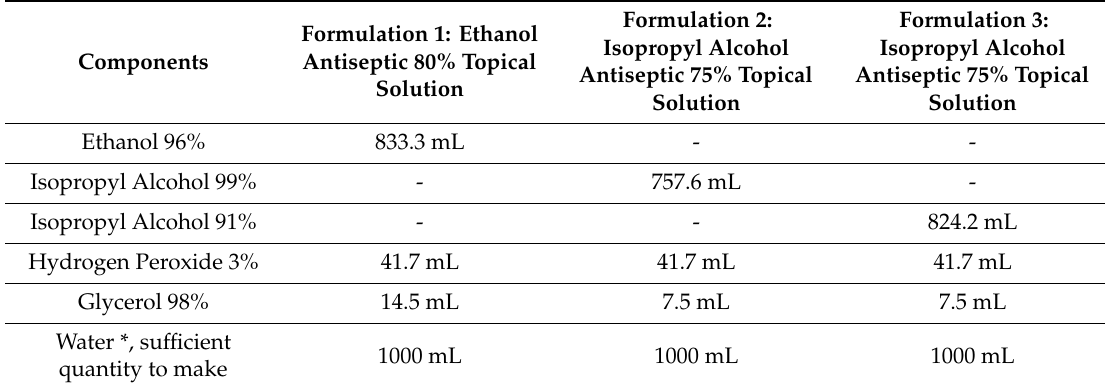
Table 3. Formulation composition for compounding alcohol-based hand sanitizer (ABHS) based United States Pharmacopeia (USP) and World Health Organisation (WHO) recommendations